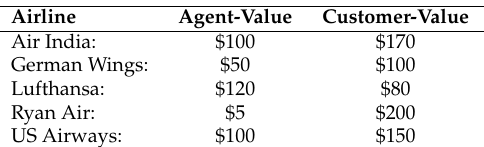
Table 6. A travel agent